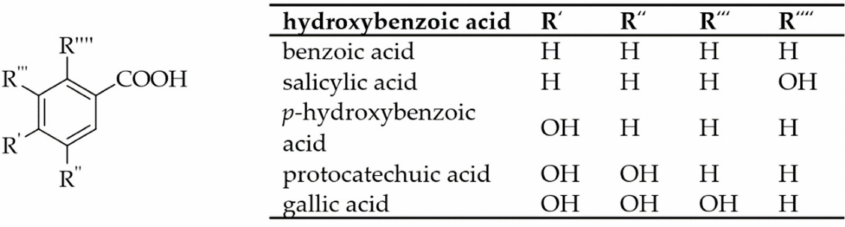
Figure 1. The structures of hydroxybenzoic acid derivates.